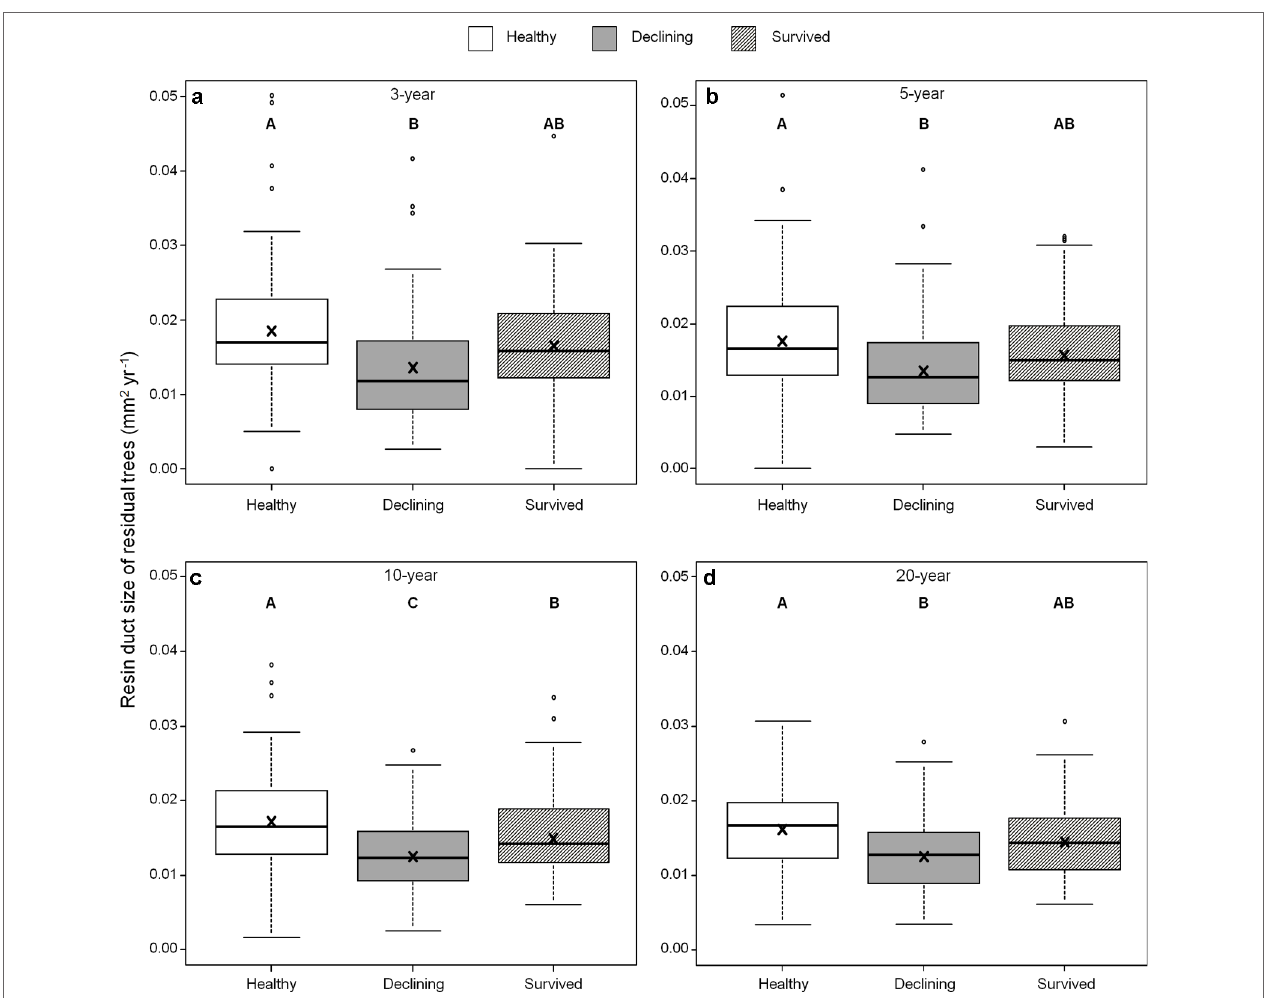
FIgURe 6 | Resin duct size of three categories (healthy, declining, survived) of residual Pinus contorta var. latifolia trees in four most recent growth periods (3 (a) , 5 (b) , 10 (c) , 20 years (d) ). Significant differences among three tree categories were indicated by different letters based on the results of linear mixed-effects models (α = 0.05). In each box plot, the thick line is the median, × mark indicates the mean, the box represents the 1st and 3rd quartiles, whiskers are Tukey’s 1.5 interquartile range, and the open circles indicate outliers Resin duct size was log-transformed to stabilize the normality and homogeneity of variance of model residuals.